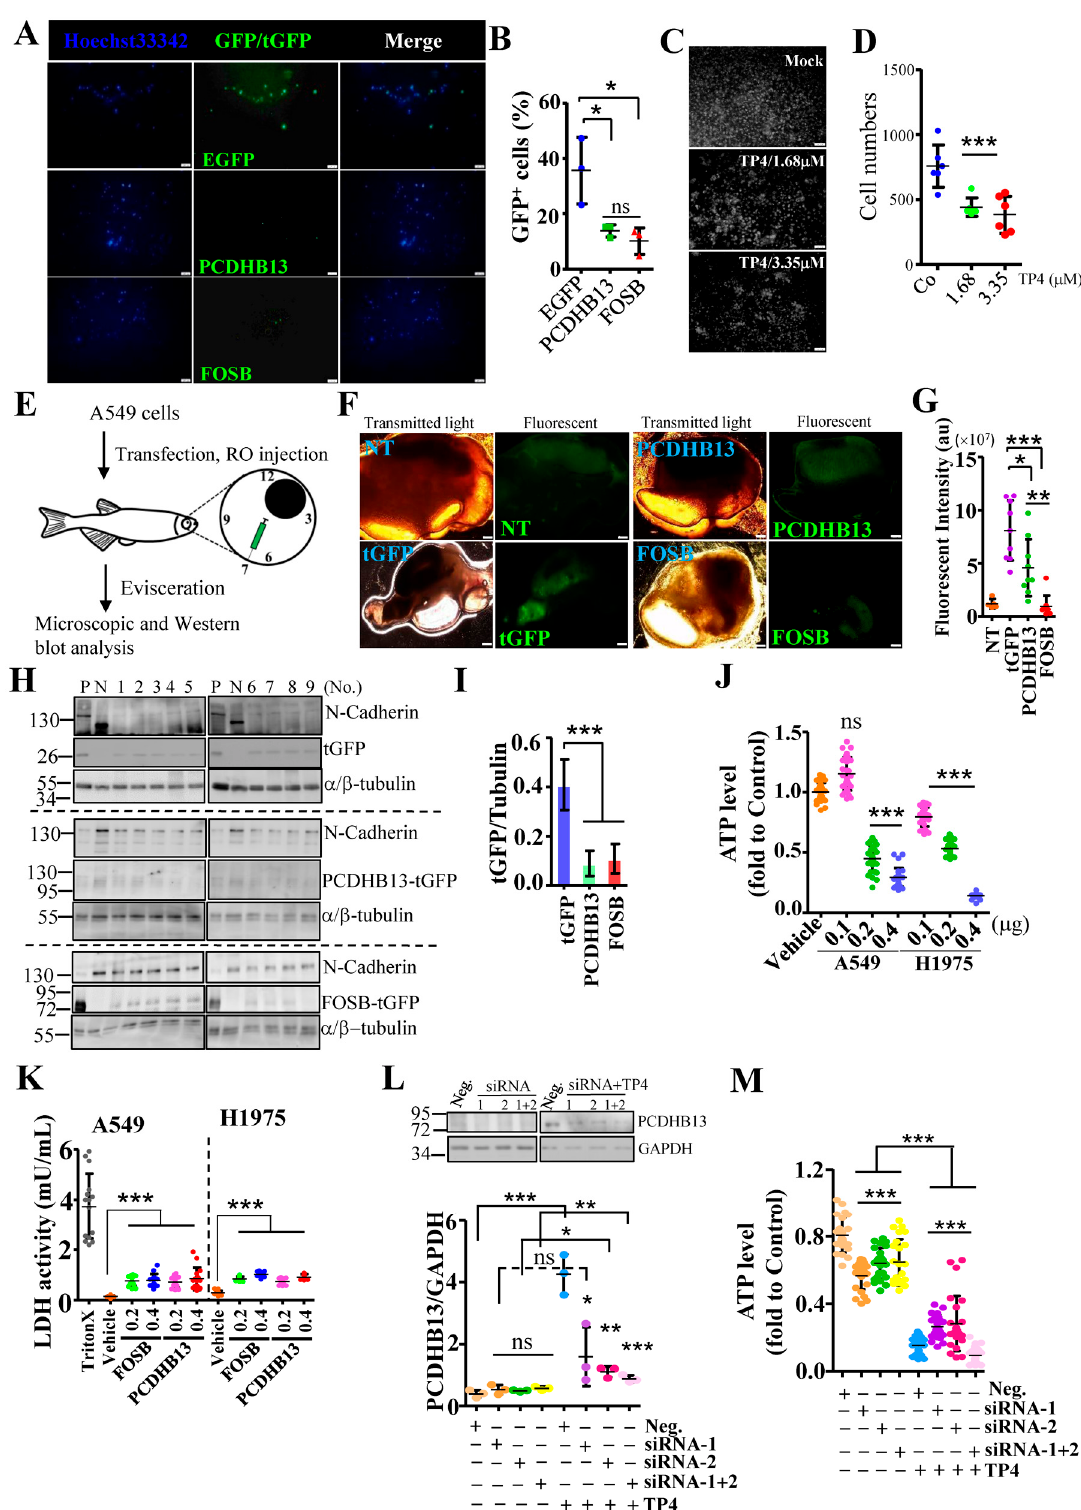
Figure 6. Elevated expression of PCDHB13 inhibits cell invasion and triggers cell death. ( A,C ) The underside of Matrigel-coated polycarbonate membranes used for cell invasion assays on EGFP-, PCDHB13-, and FOSB-transfected cells ( A ) or cells incubated with 1.68 and 3.35 μ M TP4 ( C ). Cells were stained by Hoechst33342 shown in blue ( A ) or white ( C ). Bar: 200 μ m. ( B,D ) Quantification of the cells that migrated across the membrane. Data were calculated by normalizing GFP/tGFP-positive to the total cell counts ( n = 463 in EGFP transfected groups, n = 300 in